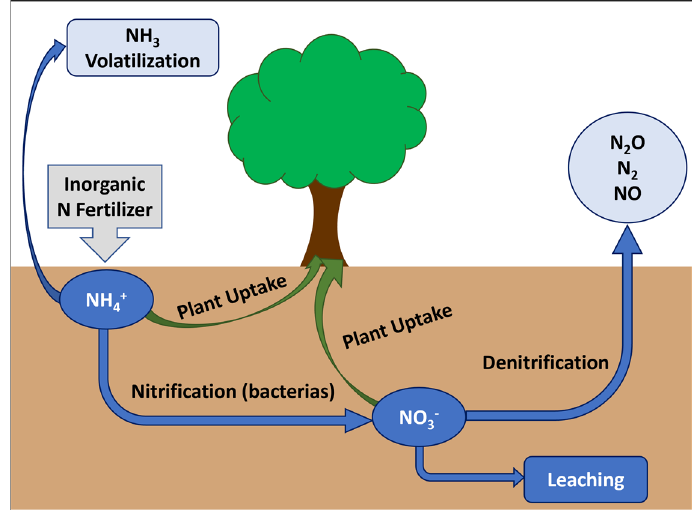
Figure 1. Inorganic nitrogen fertilizer e ff ect after soil application.